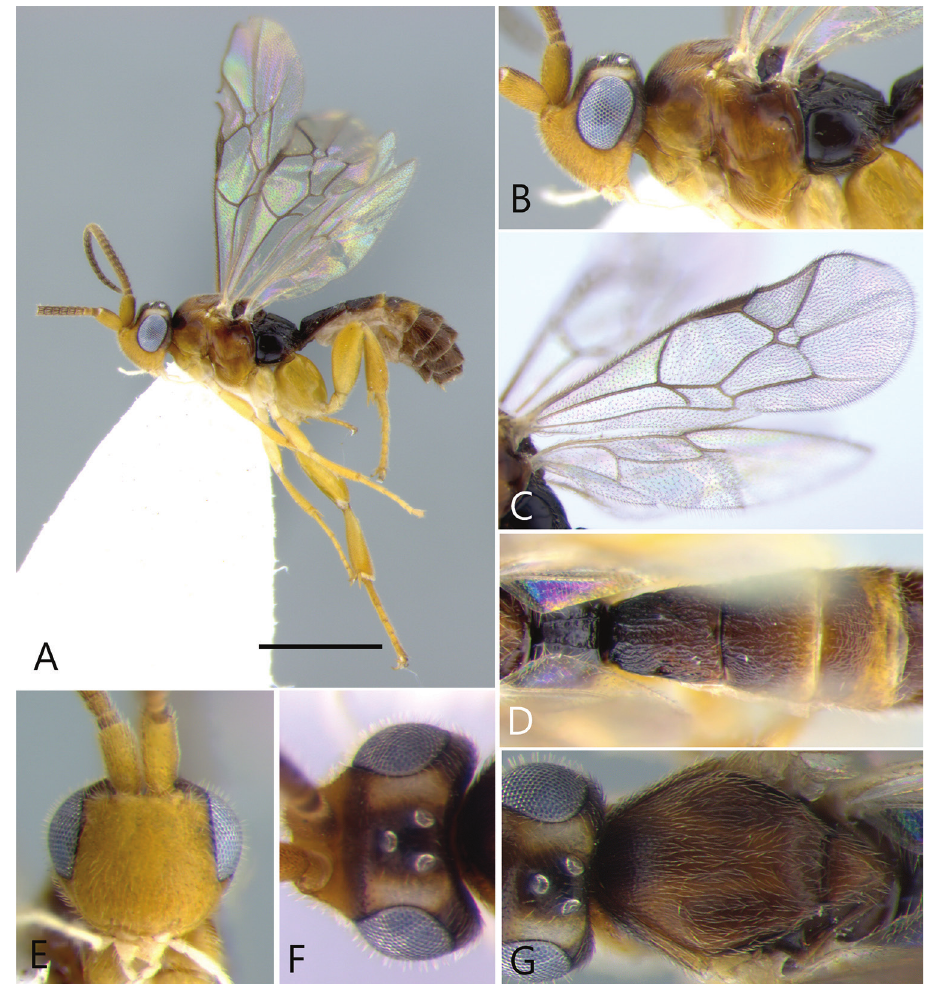
Figure 15. Orthocentrus setosus sp. nov. Holotype. A Habitus in lateral view B head and mesosoma in lateral view C wings D propodeum and first to third tergites in dorsal view E head in frontal view F head in dorsal view G mesoscutum in dorsal